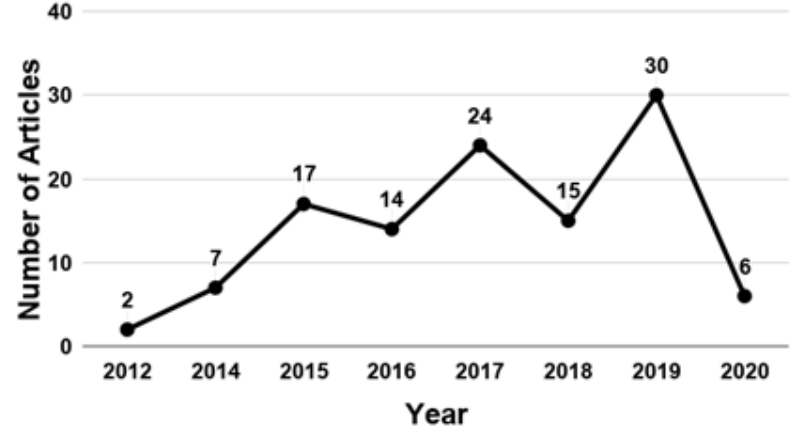
Figure 4. The selected number of studies per year for the review.